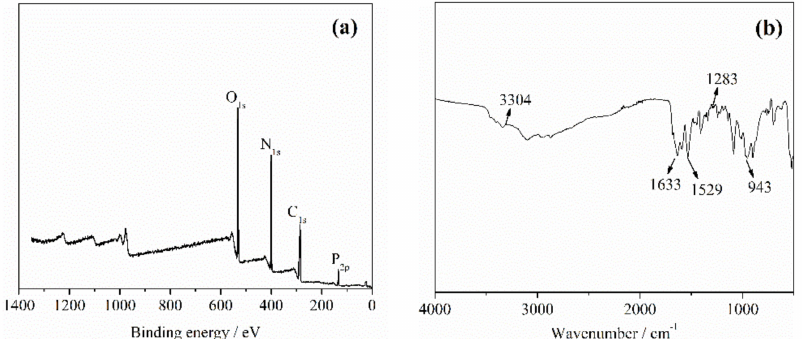
Figure 3. XPS ( a ) and FTIR ( b ) spectra of flame retardant.